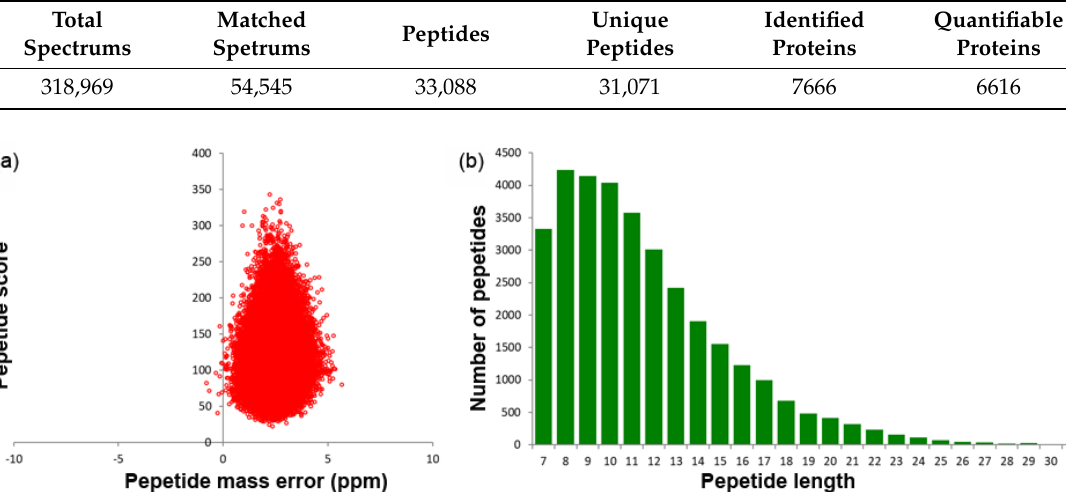
Table 1. Detail information of the identified proteins overview.